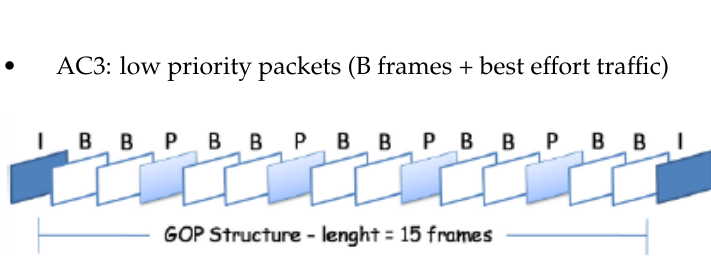
Figure 1. Structure of a group of pictures (GoP) formed by IPB video